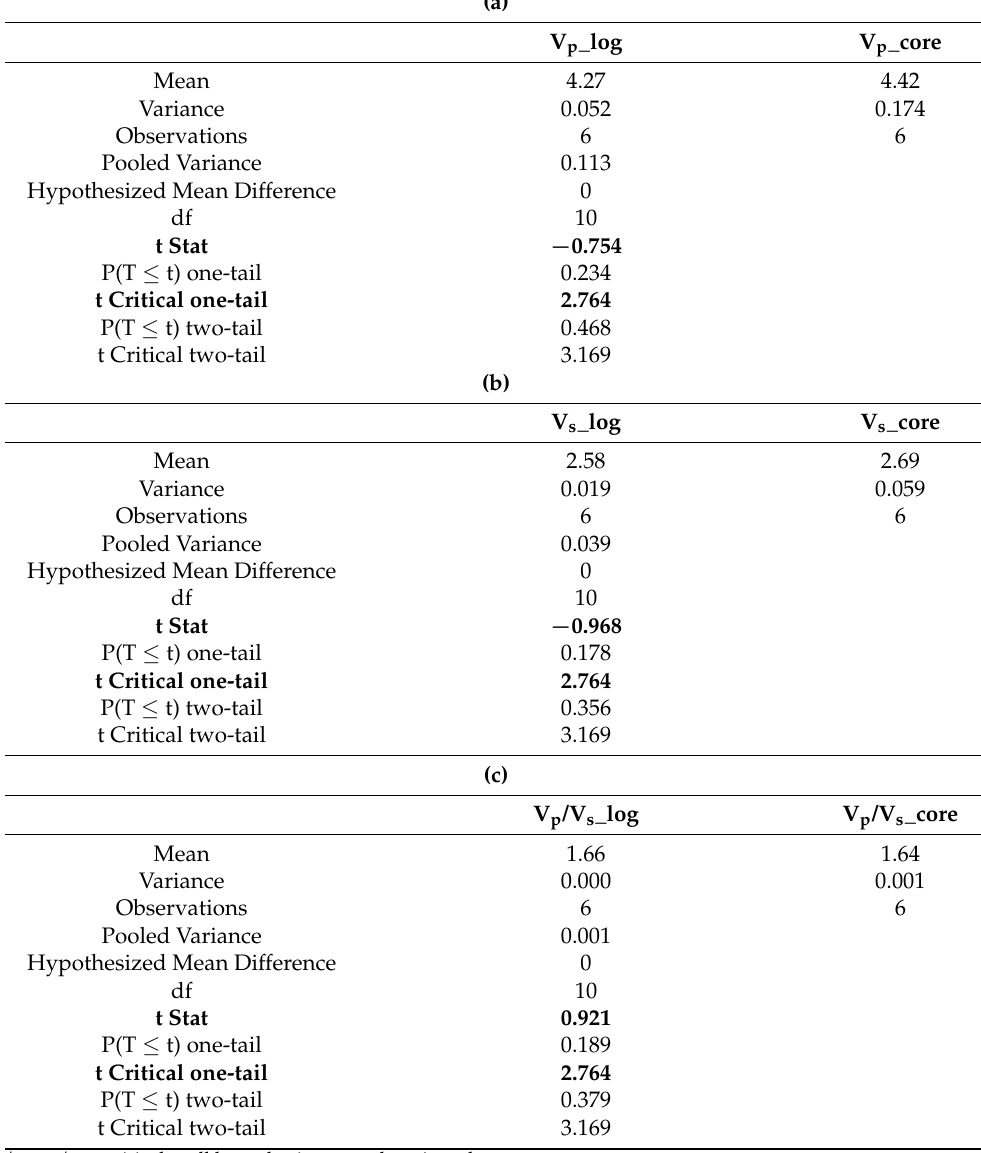
Table 5. (a) Student t -test for the co-located sonic log and ultrasonic core P-wave velocity measure- ments (after fluid substitution to in situ saturations) in the Wolfcamp formation, Delaware basin. Result indicate there is no significant difference between the mean of the sonic log and ultrasonic core measurements. (b) Student t -test for the co-located sonic log and ultrasonic core S-wave velocity mea- surements (after fluid substitution to in situ saturations) in the Wolfcamp formation, Delaware basin. Result indicate there is no significant difference between the mean of the sonic log and ultrasonic core measurements. (c) Student t -test for the co-located sonic log and ultrasonic core V p /V s ratio (after fluid substitution to in situ saturations) in the Wolfcamp formation, Delaware basin. Result indicate there is no significant difference between the mean of the sonic log and ultrasonic core velocity